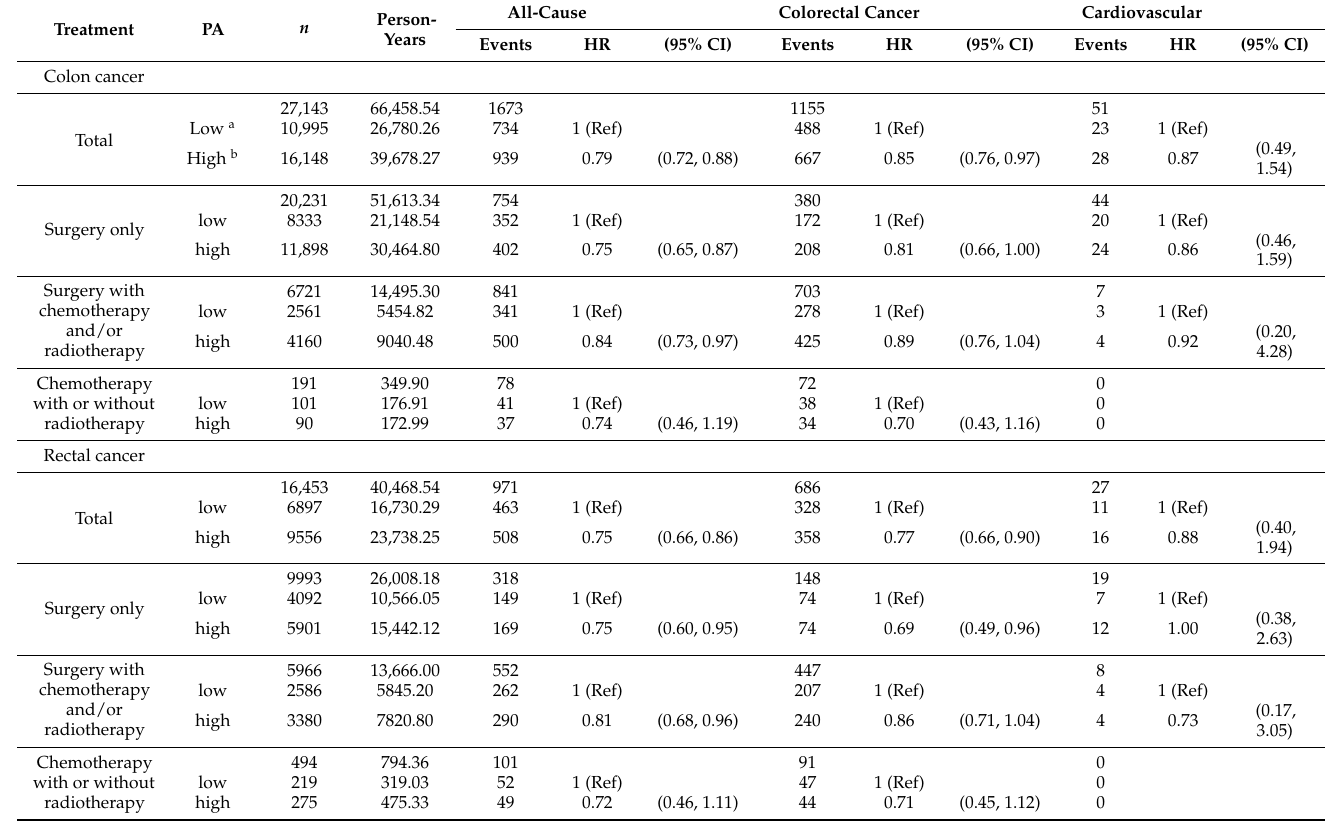
Table 3. Post-diagnosis physical activity and all-cause/colorectal cancer/cardiovascular mortality in colon and rectal cancer